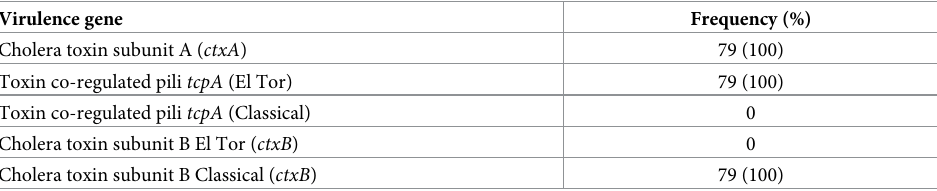
Table 1. Frequency of toxin and virulence genes detected (n =